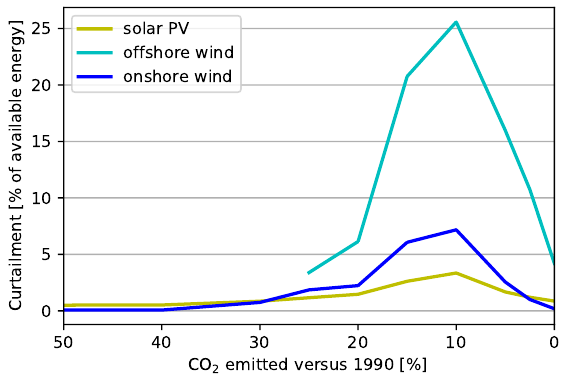
Figure 8. Curtailed variable renewable energy, as a percentage of the available